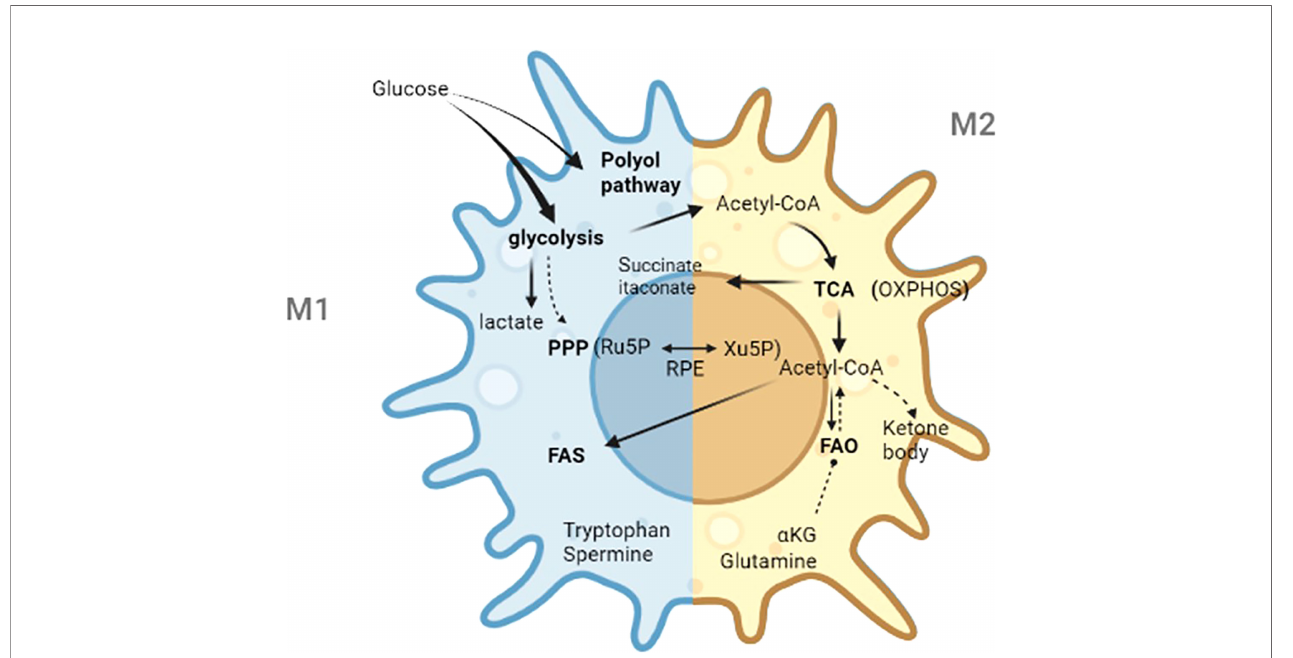
FIGURE 2 | The main metabolic pathways and crucial metabolites in macrophages. Ru5P, d-ribulose-5-phosphate; Xu5P, d-xylulose-5-phosphate; RPE, ribulose 5- phosphate 3-epimerase; PPP, pentose phosphate pathway; TCA, tricarboxylic acid; FAS, fatty acid synthesis; FAO, fatty acid oxidation; Acetyl-CoA, acetyl-Coenzyme A; OXPHOS, oxidative phosphorylation; a -KG, a